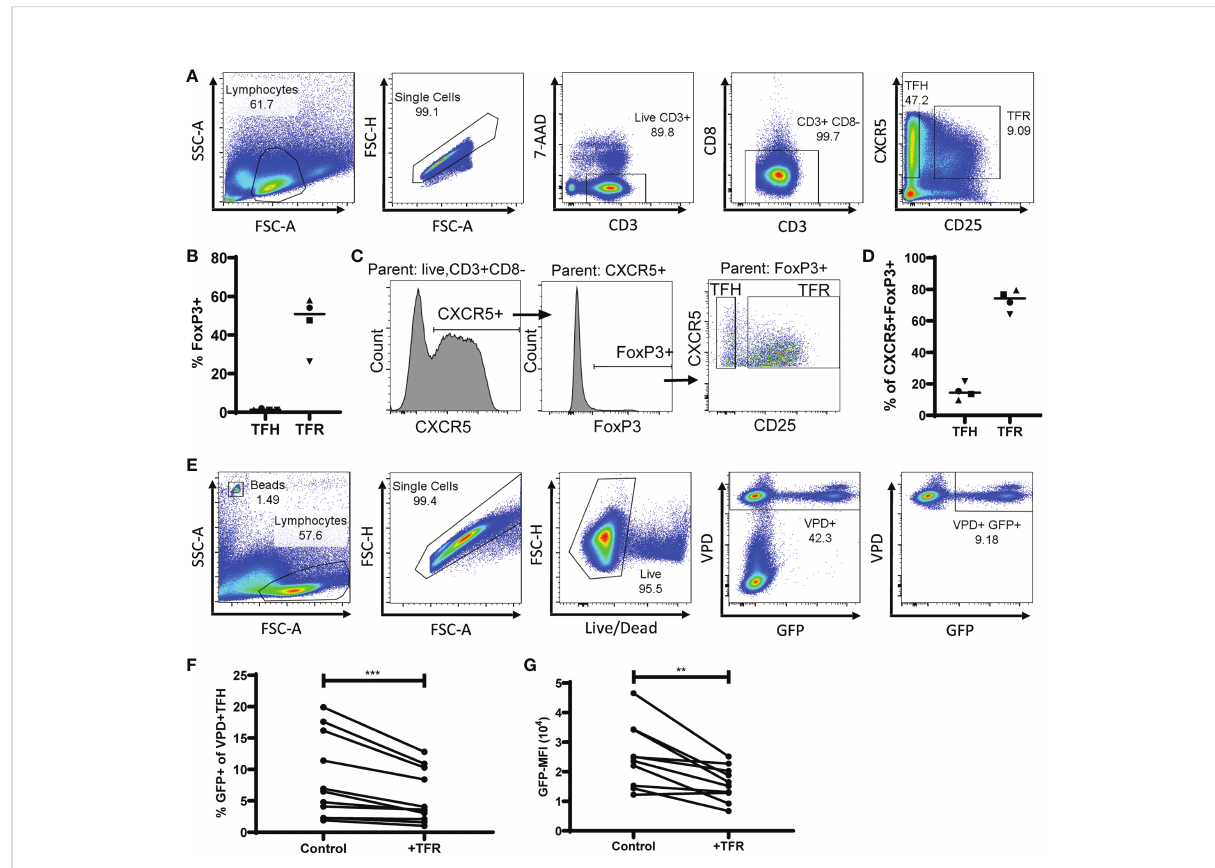
FIGURE 1 TFR reduce CXCR4-tropic HIV replication in TFH. (A) A representative gating strategy for sorting TFH (CD3+CD8-CXCR5+CD25 lo ) and TFR (CD3+CD8-CXCR5+CD25 hi ) from CD4-enriched disaggregated tonsil cells. (B) FoxP3 expression in TFH and TFR populations (n=4). (C) Representative gating strategy to determine CXCR5 + FoxP3 + expression in TFH and TFR populations. (D) Percentages of CXCR5 + FoxP3 + cells gated as TFH or TFR (n=4). (E) Representative gating strategy for detection of VPD + TFH and GFP expression in TFH cocultures. TFH were spinoculated with CXCR4-tropic HIV GFP reporter virus, labeled with VPD, and cultured for fi ve days at a ratio of 1:1 with uninfected, unlabeled TFH (control) or TFR in media supplemented with 10 IU/ml IL-2 and 5 m M saquinavir (n=11). After fi ve days, percentages of GFP + VPD +